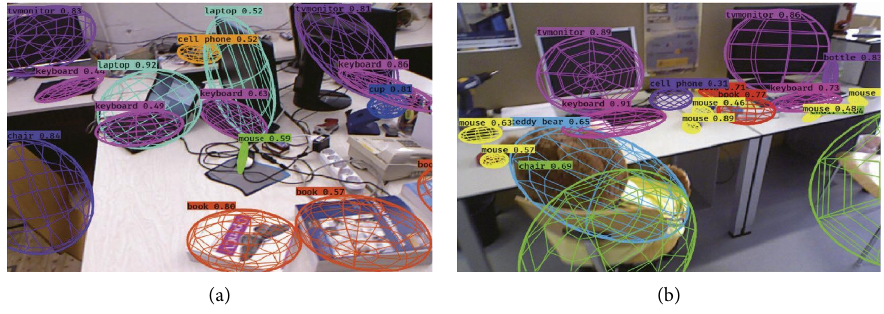
Figure 21: Te semantic map, an excerpt from